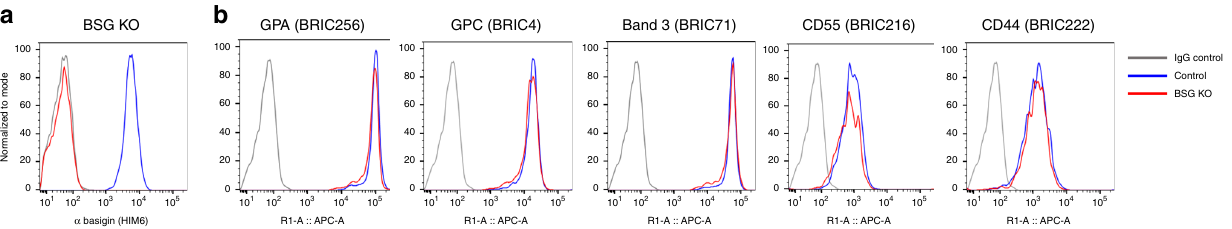
Fig. 3 CRISPR-mediated gene editing of BEL-A cells enables generation of BSG knockout reticulocytes. a Flow cytometry histogram illustrates basigin (HIM6) labeling in reticulocytes derived from unedited (blue) and basigin knockout (red) BEL-A cell lines compared with IgG isotype control (gray). b Flow cytometry histograms illustrate unaltered expression of indicated host receptors between reticulocytes derived from unedited and basigin knockout BEL-A cells. Source data are provided as a Source Data fi